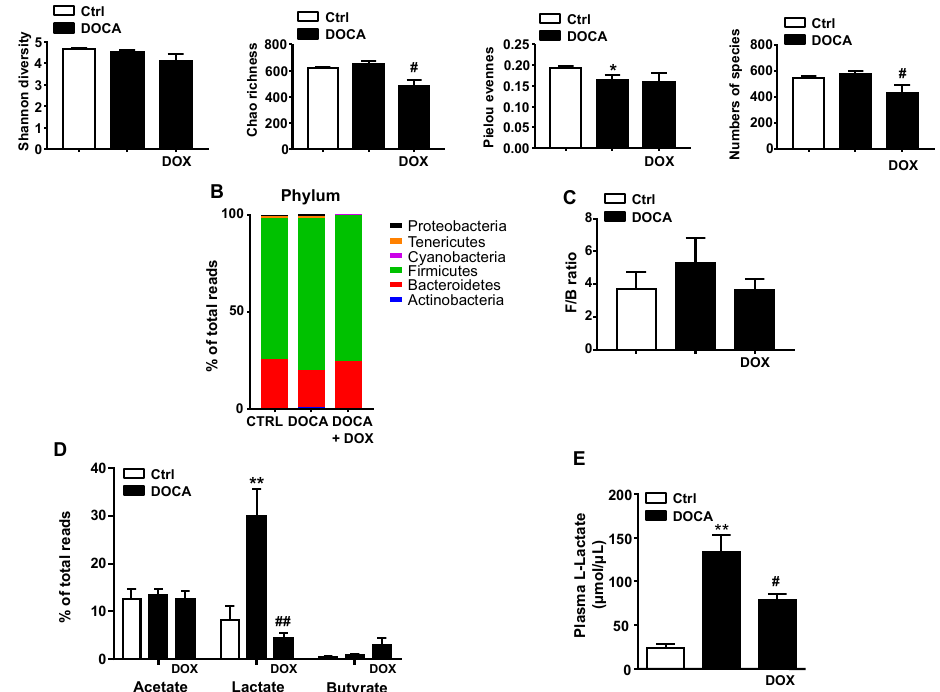
Figure 2. Effects of Doxycycline (DOX) on phyla changes in the micro-ecological parameters and gut microbiota composition. Analysis of the 16S ribosomal DNA in stool samples. ( A ) Bacterial diversity, richness, evenness and numbers of species as markers for differences in microbial composition among groups. ( B ) Phylum breakdown of the most abundant bacterial communities in each group. ( C ) The Firmicutes/Bacteroidetes (F/B) ratio as a biomarker of gut dysbiosis. ( D ) Relative proportions of acetate-, lactate- and butyrate-producing bacteria. ( E ) Plasma lactate concentrations ( µ mol/ µ L) in control (Ctrl) and DOCA-salt rats. Data represented as means ± sem ( n = 6–8). * p < 0.05 and ** p < 0.01 versus Ctrl group; # p < 0.05, ## p < 0.01 versus DOCA-salt group.